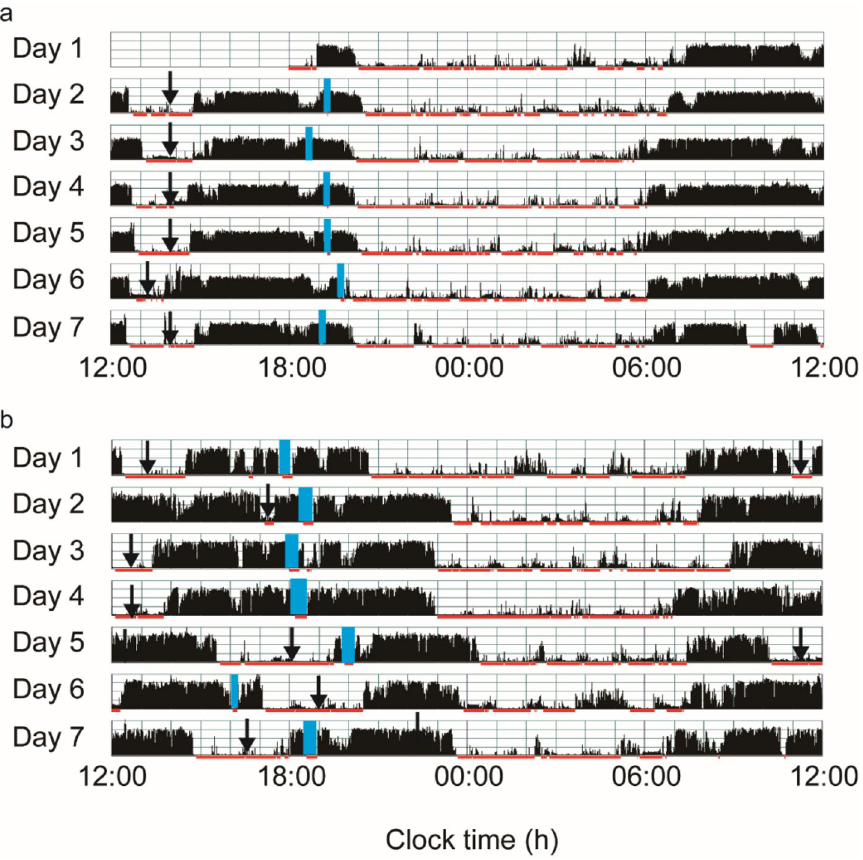
Figure 1. The actograms show representative daily activity-rest patterns of preterm toddlers with stable daily wake times ( a ) (an infant with DQ96) and unstable daily wake times ( b ) (an infant with DQ73). The vertical axis shows the 7 consecutive observation days and the horizontal axis shows the course of each 24 h day from 12:00 h (00:00 pm). Activity counts per minute are represented by the height of the vertical black bars on each actogram. The arrows and the blue rectangles indicate naps and bathing periods, respectively. The red underlines are the periods that were automatically judged as sleep periods by the actigraph software. Note that the wake times are recognized as relatively regular starts of the vertical black bars at around 6:00 h (06:00 am) in ( a ) but as irregular starts of the vertical black bars between 6:00 h (06:00 am) and 9:00 h (09:00 am) in ( b ).